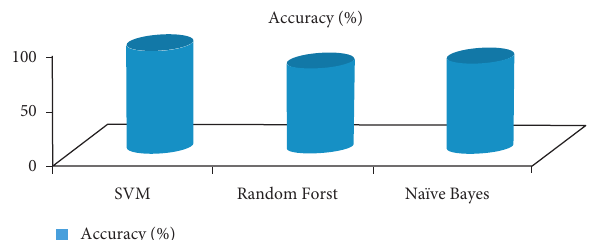
Figure 3: Accuracy of machine learning algorithms.